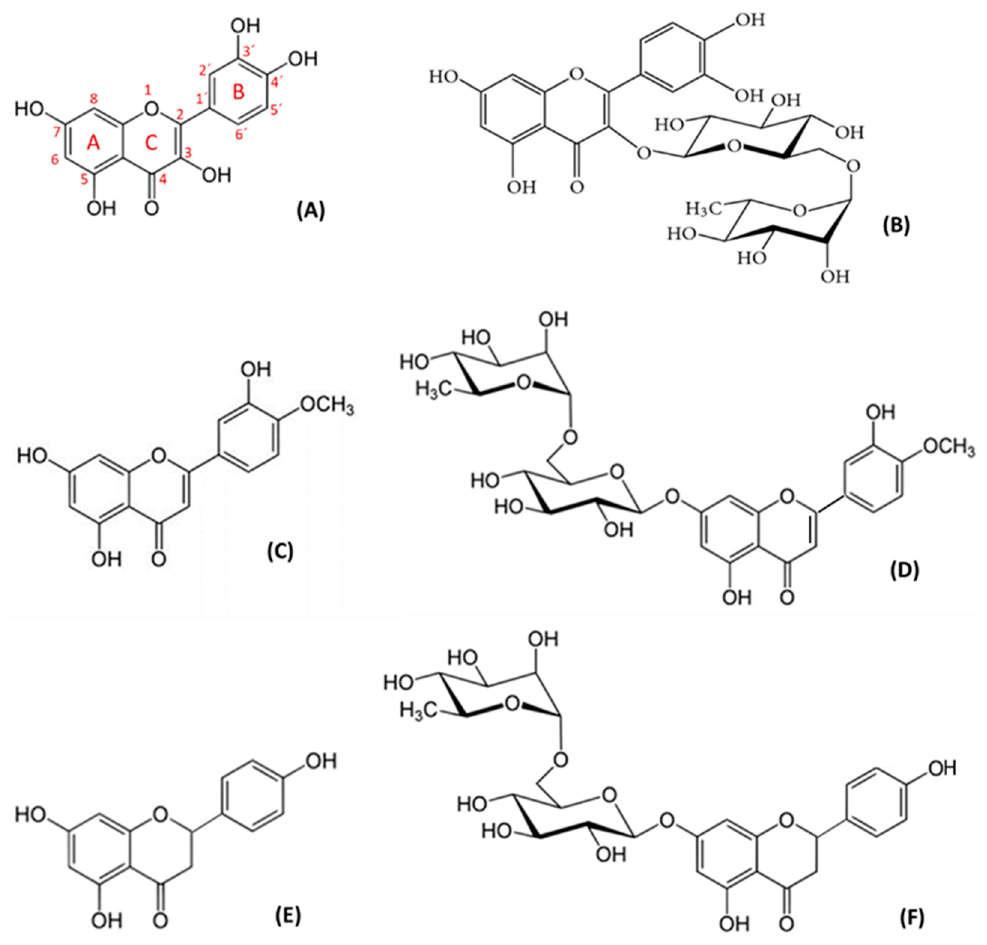
Figure 6. Chemical structure of flavonoids: ( A ) Quercetin, ( B ) rutin, ( C ) diosmetin, ( D ) diosmin, ( E ) naringenin, and ( F ) naringin.